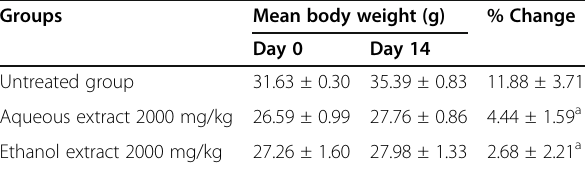
Table 5 Evaluation of percent body weight change in the untreated, aqueous and ethanolic extract groups during acute toxicity experiments Groups